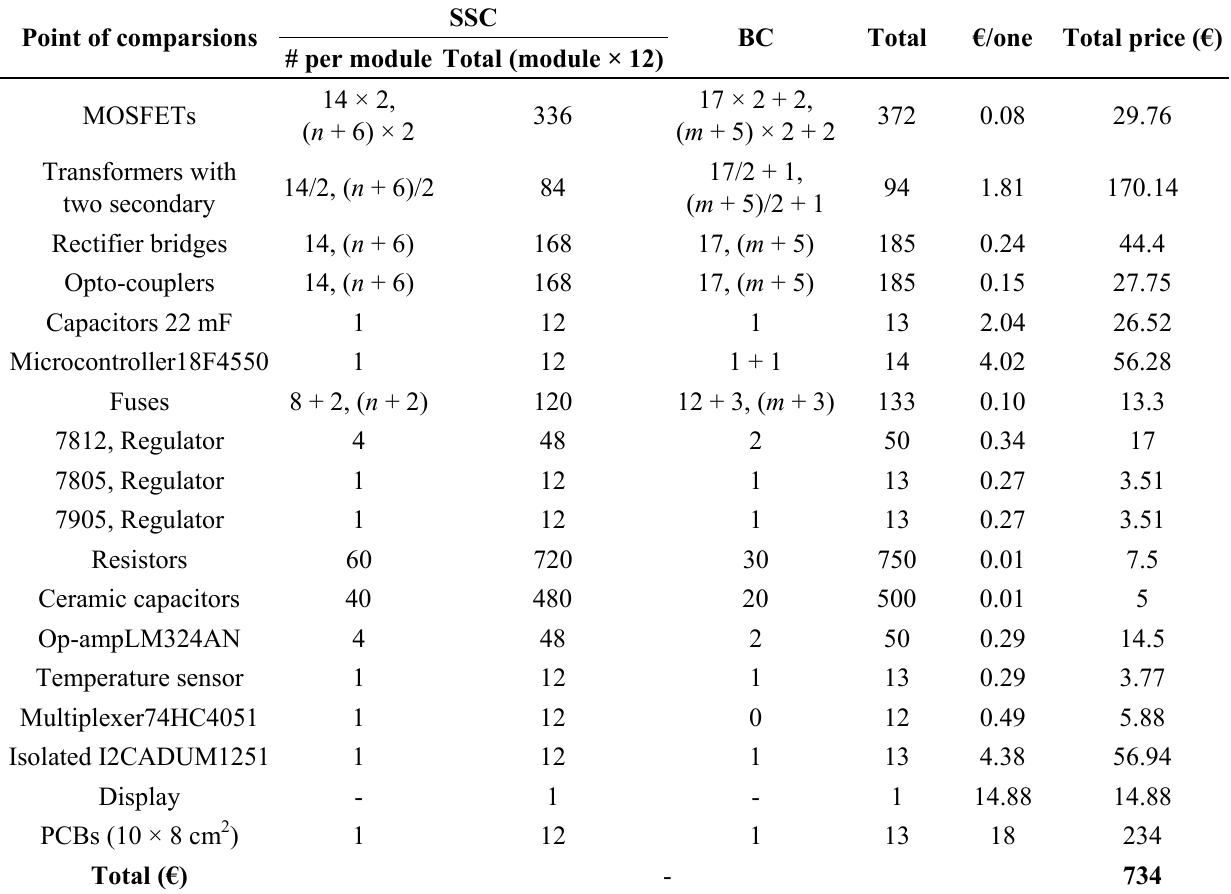
Table 5. Battery balancing system elements and